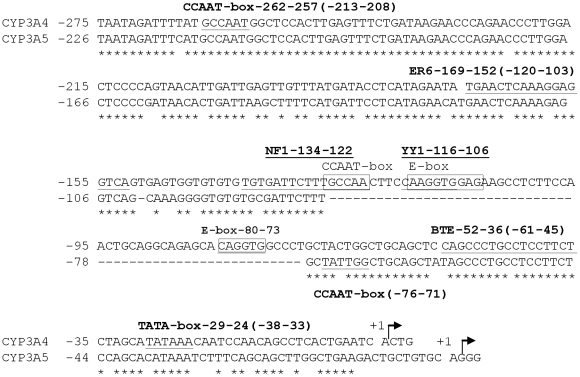
Sequence comparison and distribution of regulatory elements in the human CYP3A4 and CYP3A5 proximal promoters.Identical nucleotides are denoted by asterisks. The 57 bp region absent from the CYP3A5 promoter is represented as a stretch of hyphens. The transcription start sites [37], [38] are indicated by arrows. The sequence is numbered relative to the transcription start site taken as +1. The binding sites for previously characterized transcriptional regulators CCAAT-box, ER6, BTE, TATA-box, and NF1 [37], [38], [39] are underlined. The portion of the NF1 binding site described to constitute a CCAAT box, the YY1 site, and the two E-box motifs [27], [39], all contained in the 57 bp region, are boxed. The positions of binding sites are shown separately for CYP3A4 and, if applicable, in brackets for CYP3A5.